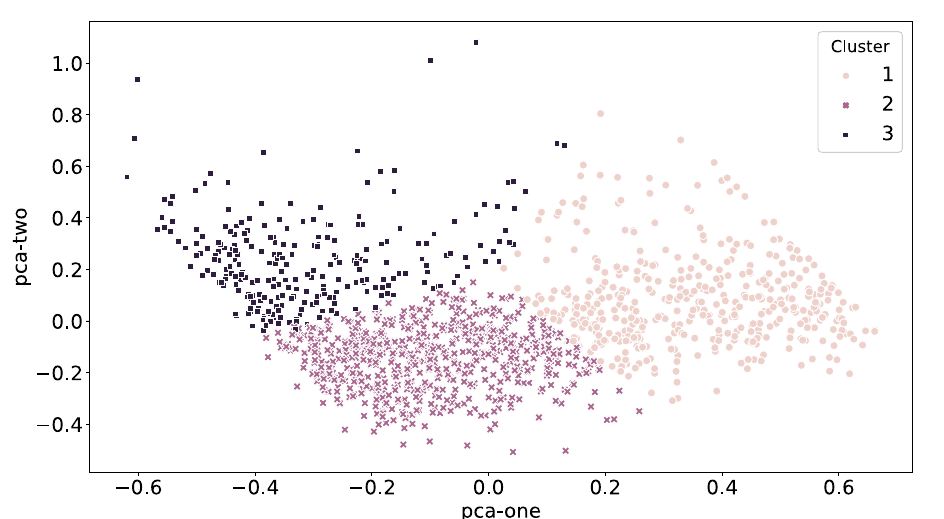
Figure 3. PCA results of the three clusters, each represented by a distinct marker. The number of samples is 594, 897, and 360, for cluster number 1, 2, and 3, respectively. X-axis or pca-one is first rank component with the variance percentage of 50.05, and y-axis or pca-two is the second rank component with the variance percentage of